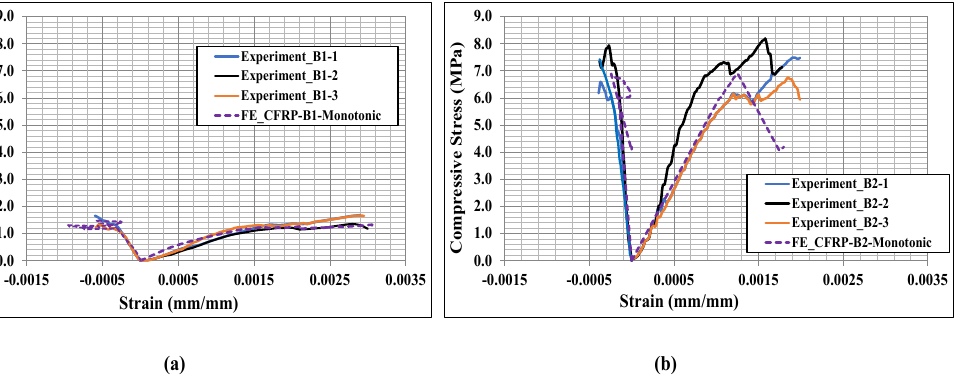
Figure 15. Stress-strain responses of CFRP-strengthened masonry wallettes constructed of different types of brick; ( a ) B1 and ( b ) B2 under monotonic loading.